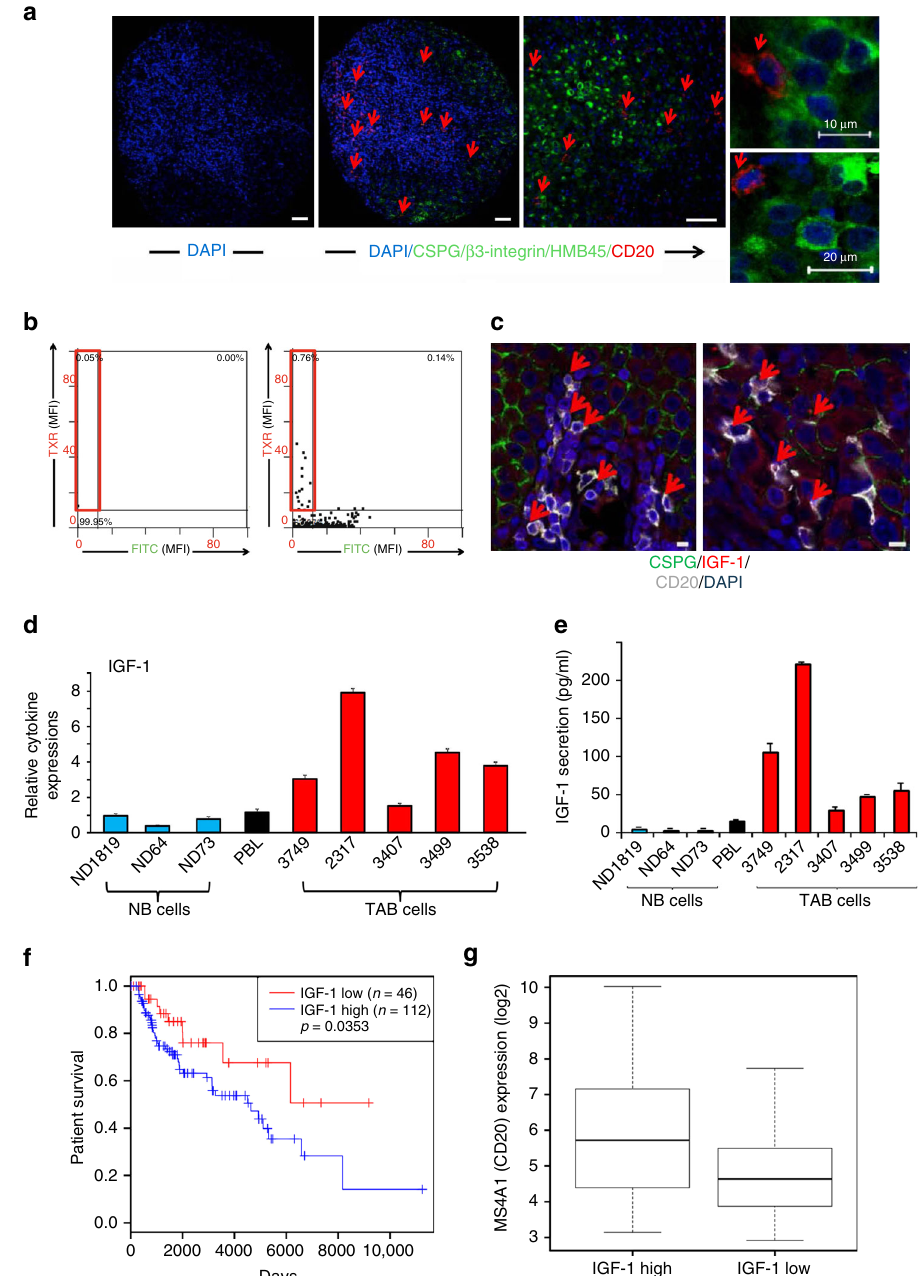
Fig. 1 a – g Prevalence of CD20 + B cells in metastatic melanoma tissues and increased IGF-1 expression in TAB cells. a , b Presence of CD20 + B cells. Representative immunostaining (TMA, 79 cores from 48 patients) for CD20 ( red ) and a three melanoma marker combination (CSPG/ β 3 integrin/HMB45 ( green )) plus DAPI nuclear stain ( blue ). a Left and middle panels : sample with predominant distribution of CD20 + , triple melanoma marker -ve B cells in the tumor stroma ( red ; left panel : isotype control). Right panel : close-up with in fi ltration of single CD20 + B cells ( red ) among melanoma cells ( green ). Scale bars : 50 μ m. Far right 2 panels : CD20 + B cells are DAPI + and triple melanoma marker -ve . Scale bars : 10 – 20 μ m. b Tissue FAXS analysis, the MFI was displayed in scattergrams for FITC-labeled CSPG/ β 3 integrin/HMB45+ and Texas red (TXR)-labeled CD20+ cells. Cutoff values were set based on isotype control staining ( left panel ). CD20+ B cells gated as CD20+, triple melanoma marker -ve cells ( right panel , red frame ). c Representative immunostainings from additional metastases (six patients ’ biopsies) stained for IGF-1 ( red ) in CD20 + ( grayish white ) CSPG -ve ( green ) B cells. Scale bars : 10 μ m. d , e Immortalized B cells (48 h, B-cells-only cultures) from melanoma tissues ( n = 5; TAB cells; red bars ) show increased mRNA/protein expression of IGF-1 when compared with immortalized B cells from peripheral blood ( n = 3; NB cells; blue bars ) and pooled total PBL of healthy volunteers ( black bars ). d mRNA transcripts were determined by qPCR with levels indicated as RQ values normalized to GAPDH and relative to control normal B cells from healthy volunteers. Bars represent mean + SE of duplicate samples. Results are representative of three independent experiments for each sample. e B-cell supernatants (48 h, B-cells-only cultures) were used for protein expression of IGF-1 (ELISA). Bars represent mean + SE of duplicate samples. f , g TCGA-SKCM patients ’ data set analyses ( n = 473). f Kaplan – Meier survival curves of 158 melanoma patients with tumors containing a high lymphocyte in fi ltrate (above median, see Methods) who were divided into high and low IGF-1 expression (by median). Log-rank test shows poor OS in patients with high IGF-1 expression. g Box plots showing signi fi cantly ( p < 0.0001, t -test) increased B-cell (MS4A1, CD20) expression levels in melanomas with high tumor IGF-1 expression NATURE COMMUNICATIONS | 8: